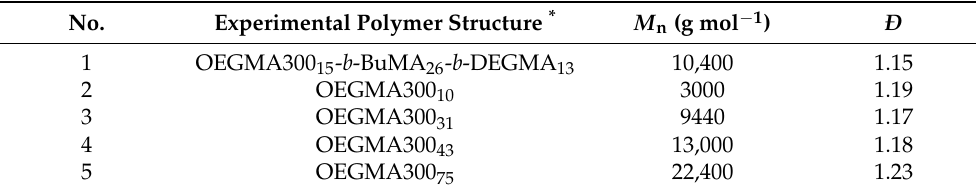
Table 1. Experimental polymer structures, experimental molar mass (number—average molar mass, M n ), and dispersity indices, where